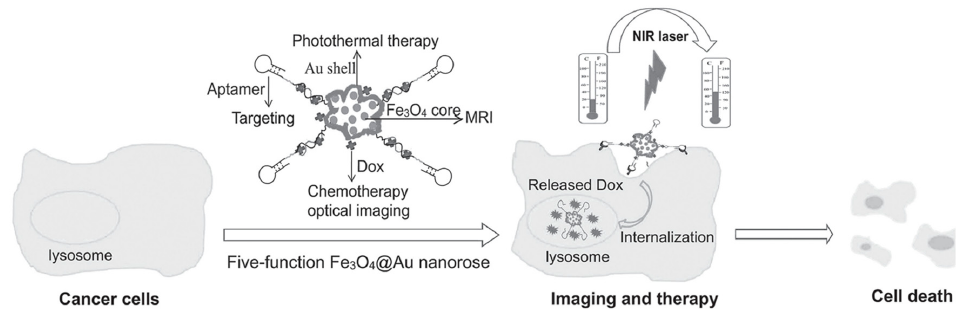
Figure 3. Schematic illustration of Fe3O4@Au nanoroses for cancer cell targeting, MRI, and optical imaging, as well as photothermal and chemotherapy. Reprinted with permission from © (2014) WILEY-VCH Verlag GmbH & Co. KGaA [40].